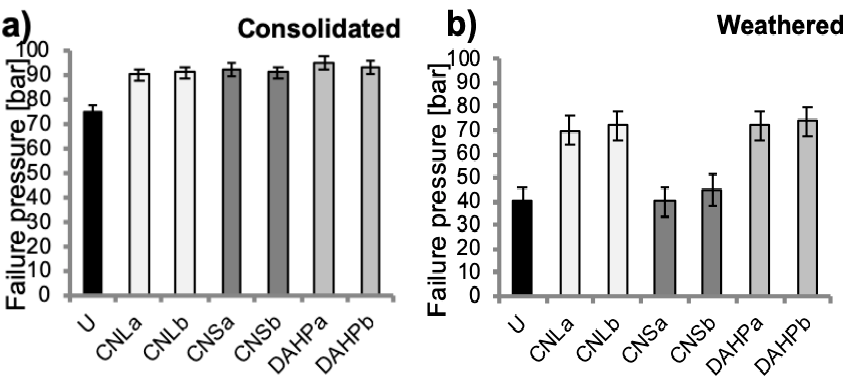
Figure 10. Point Load test on: ( a ) untreated and consolidated (unweathered) specimens; ( b ) untreated (weathered) and consolidated (weathered) specimens